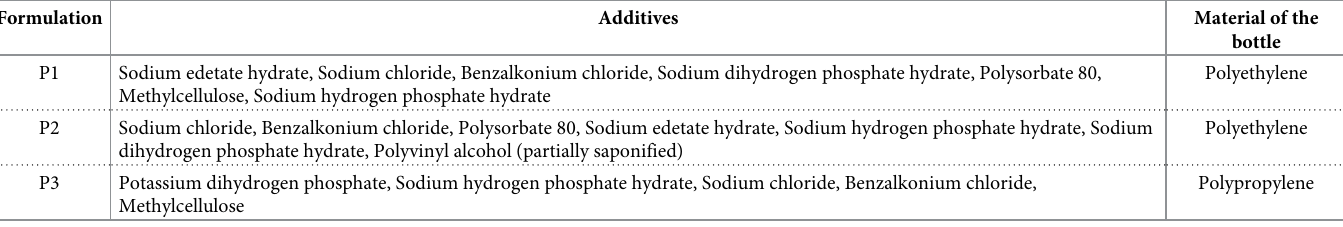
Table 1. Product characteristics of 0.1% FLU ophthalmic suspensions used in this study. Formulation